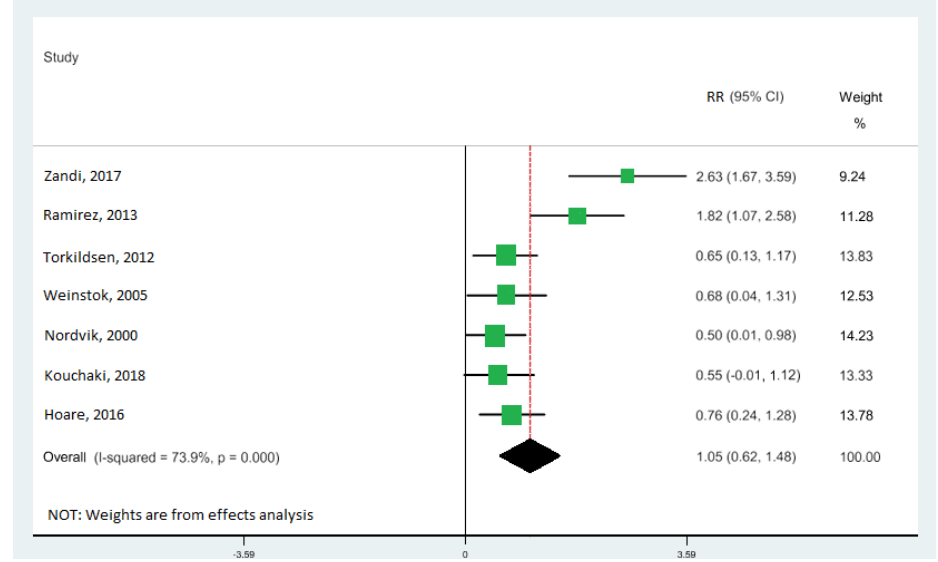
Figure 5. Forest plot of the highest vs. lowest meta-analysis of docosahexaenoic acid (DHA) effects on Expanded Disability Status Scale (EDSS) score. RR and 95% CI are abbreviations of the relative risk and 95% confidence interval, respectively [10,11,33,34,40–42].